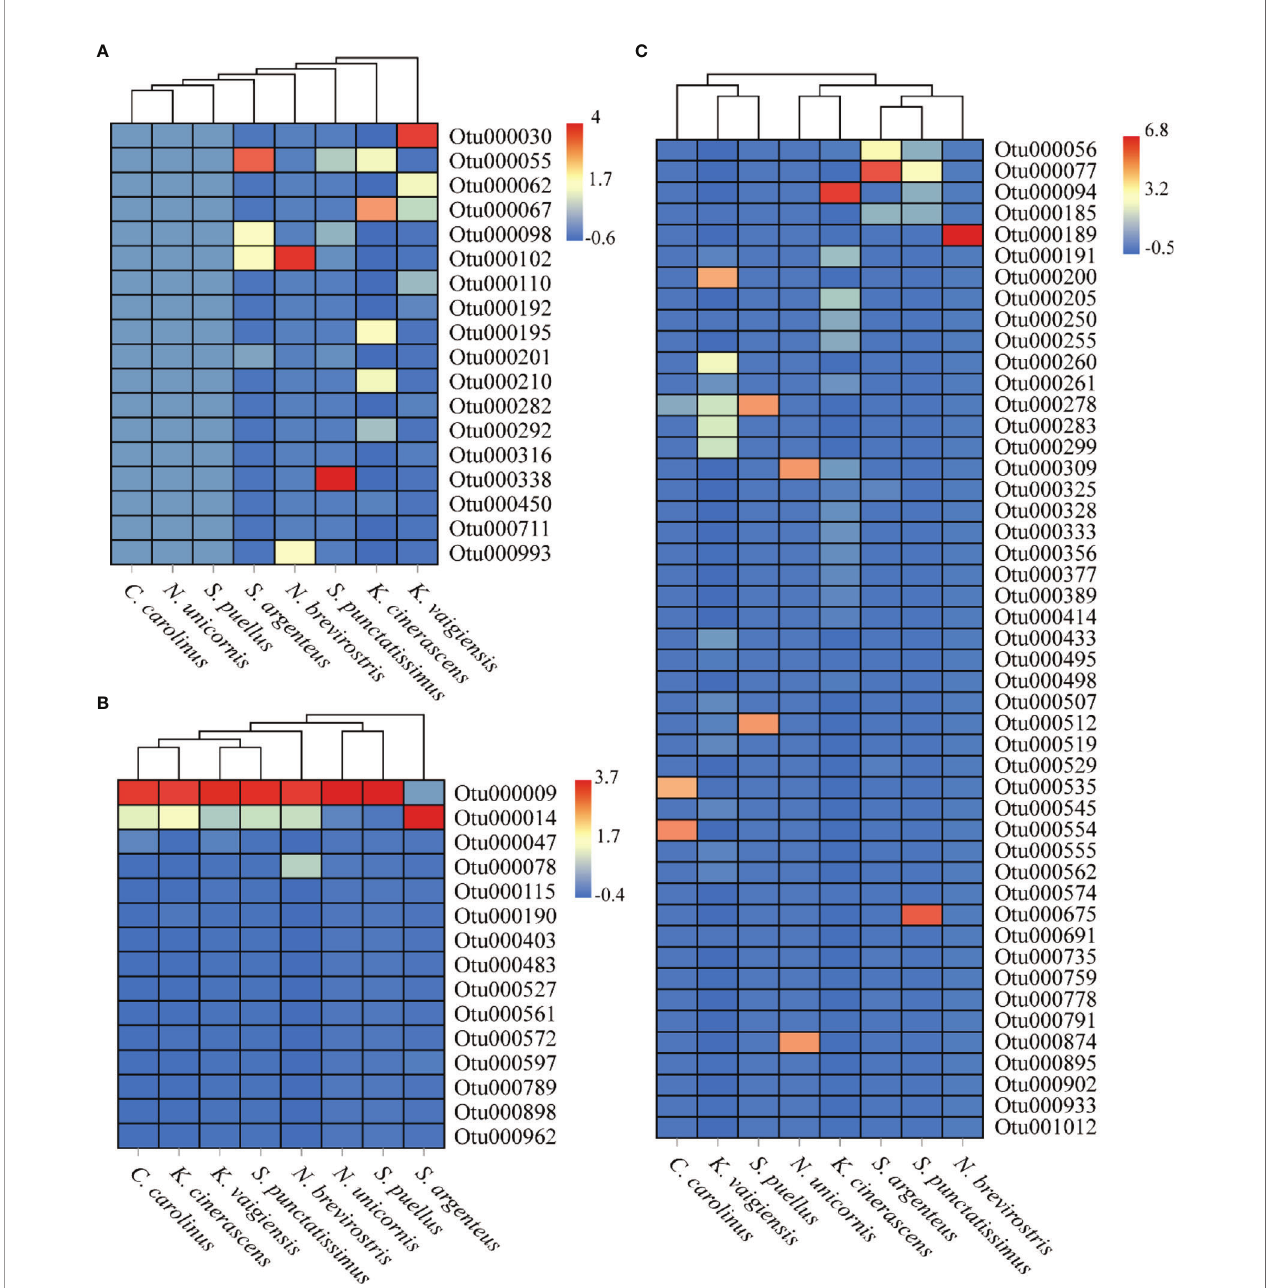
FIGURE 4 | Heat map of the relative abundance of 18S rRNA sequences af fi liated with different phyla found in the intestinal contents of eight coral reef fi sh species which were collected from the Xisha Islands, China. (A) Chlorophyta, (B) Ochrophyta, (C)